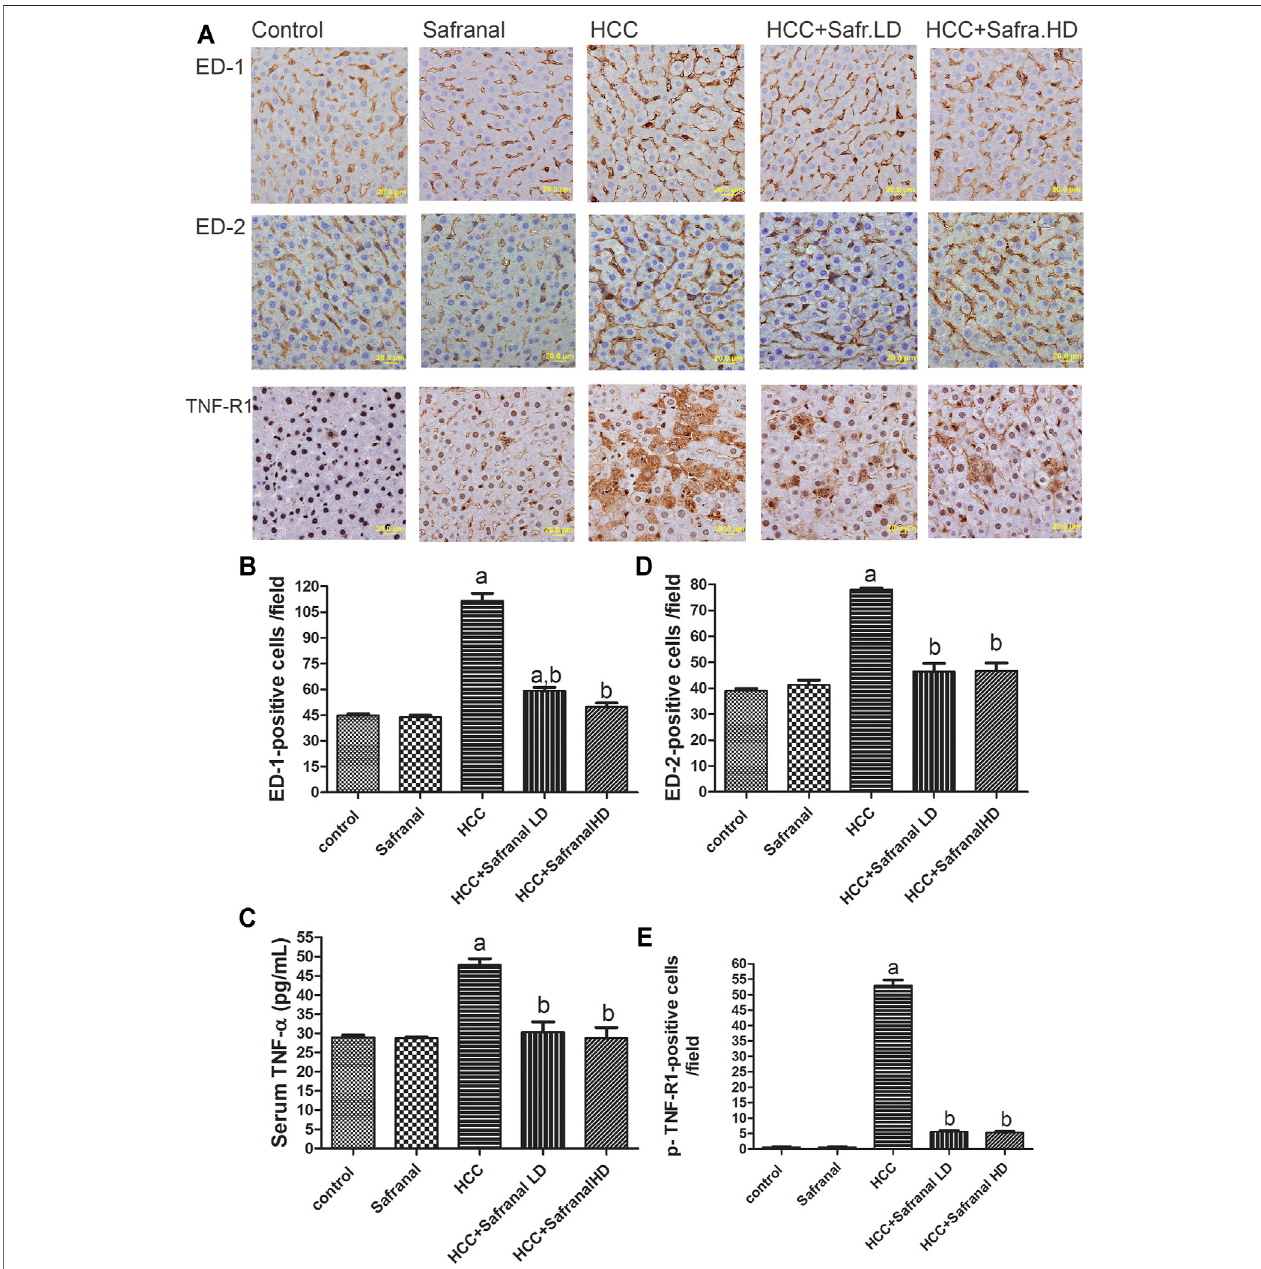
FIGURE4| SafranalreducestheupregulationofED-1,ED-2,andp-TNF-R1inliverandTNF- α inserumofHCCrats. (A) Theupperpanelarerepresentativeimages of immunohistochemical staining with ED-1, ED-2, and p-TNF-R1 in the liver section from all the groups. (B – D) The positive expression of cells in each section was calculatedbycountingthenumberofbrownstainingin10 fi eldsat×400magni fi cationsthenthenumberofpositivecells/ fi elds. (E) ShowsquantitativeanalysesofTNF- α in serum. Data are represented as mean ± SEM for six animals in each group. Signi fi cance was determined by one-way ANOVA followed by Dunnett ’ s t -test: a p < 0.05 vs. control group, b p < 0.05 vs. HCC group.